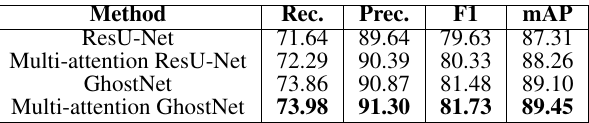
Table 2. ResU-Net and GhostNet Architectures. Symbols: C (strided convolution), MP (max-pooling), RB (residual block), GB (ghost block), US (bilinear up-sampling), CL (Output classes). The values in parenthesis refer to (Kernel Height x Kernel Height, Number of filters).